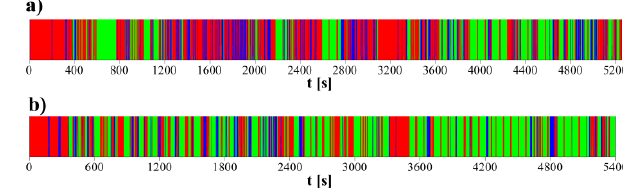
Fig. 14. Registration of the indicator operating during the run: a) in which the driver does not use the indications, b) in which the driver uses the Fig. 11. Speed and time of day during the exemplary run of the first part of the route